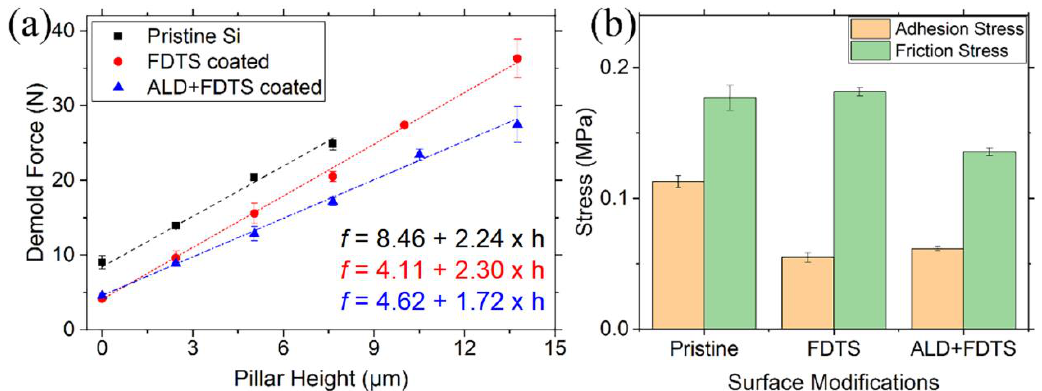
Figure 14. ( a ) Demolding force versus structural height of a pillar array mold with various surface modifications. ( b ) The fitted slope and intercept were used to calculate adhesion and friction force per unit area. Reprinted with permission from [133]. Copyright 2021 Elsevier.